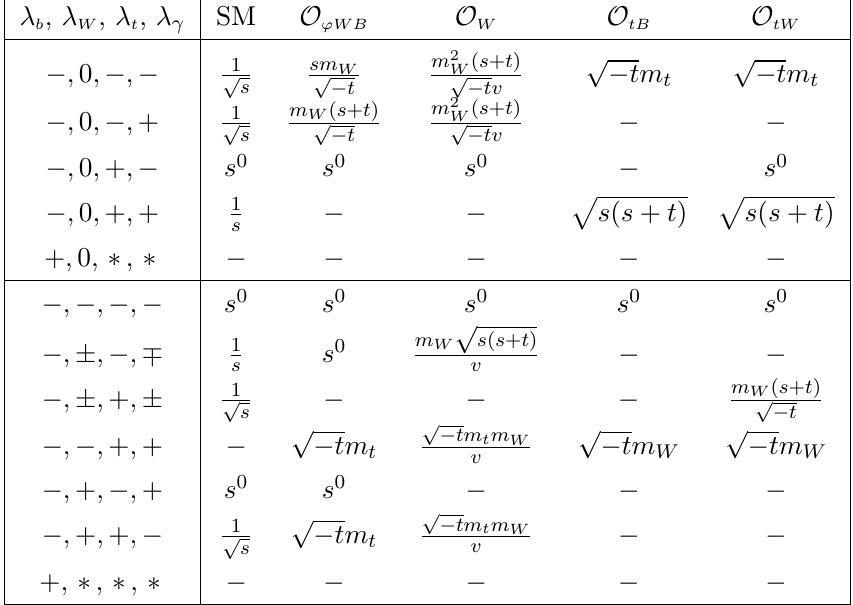
t v ) for bW + t(cid:13) scattering. (cid:24) (cid:0) (cid:29) ! ’ indicate any combination of ; . See (cid:3) (cid:6) (cid:7)